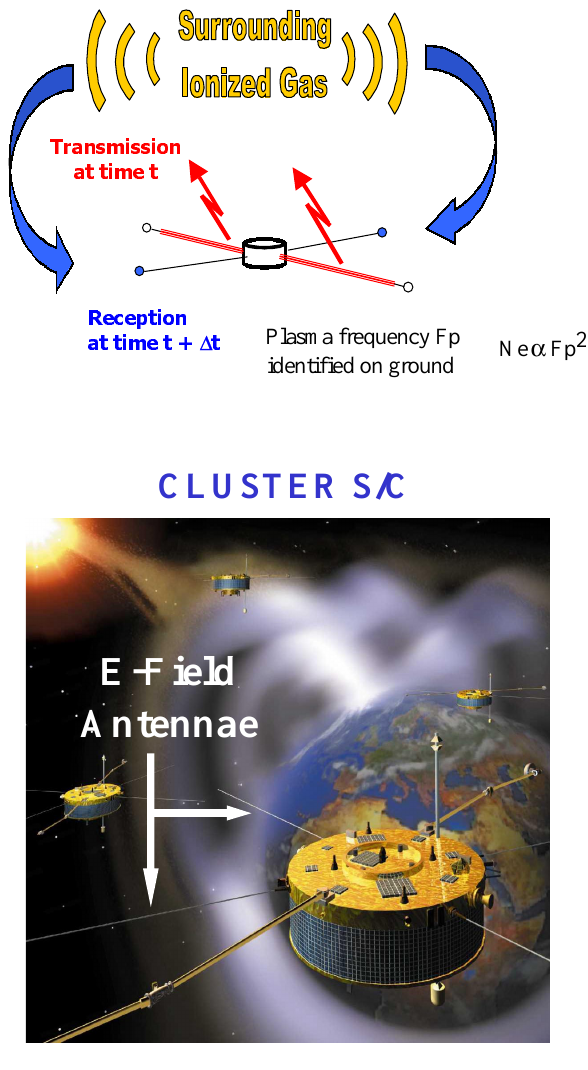
Fig. 1. Whisper relaxation sounder principle of measurements (top), EFW long double sphere electric antennae used by Whisper (bot-